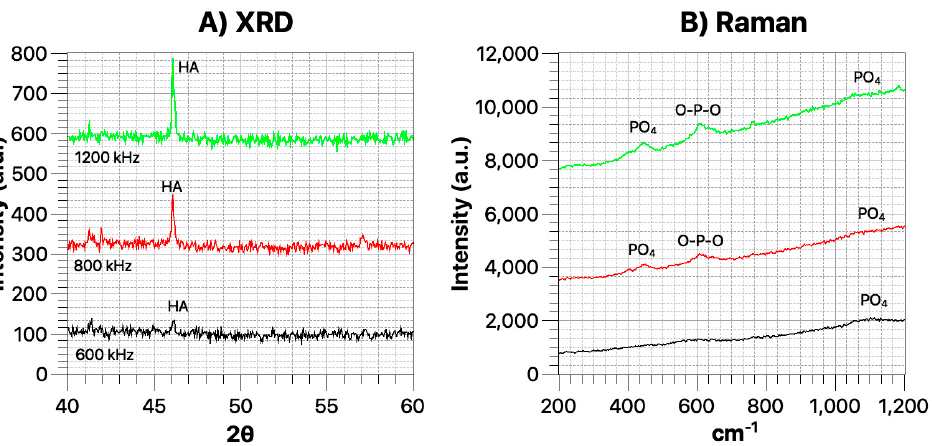
Figure 12. ( A ) XRD pattern and ( B ) Raman spectrum of glass samples coated by titanium with different laser frequencies after 4 days immersion in SBF.